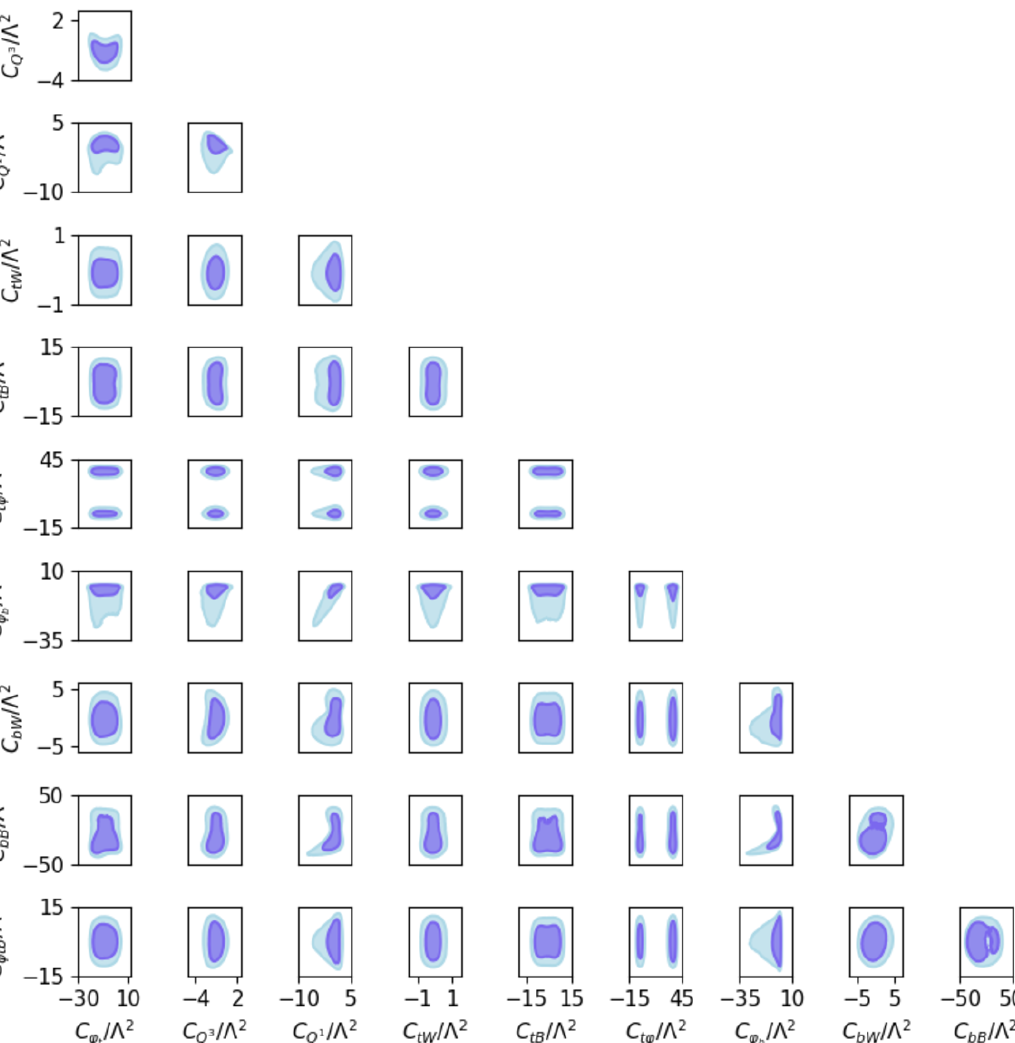
Figure 5 . Allowed regions after the (cid:12)t to the LHC and LEP/SLC measurements in table 1. The 68% and 95% probability regions are shown for each pair of the ten e(cid:11)ective operator coe(cid:14)cients that a(cid:11)ect the electro-weak interactions of the top and bottom quarks. The top-quark Yukawa operator is marginalized over. All Wilson coe(cid:14)cients are in units of TeV (cid:0) 2 .